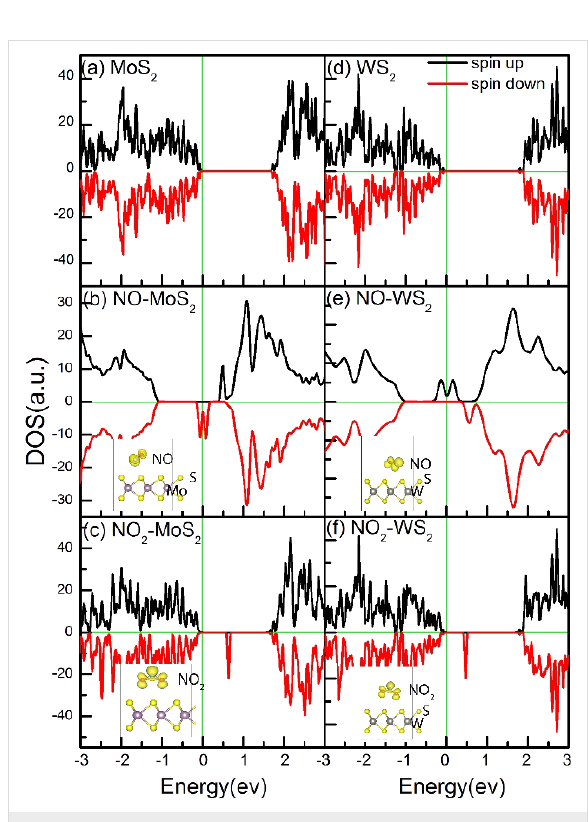
Figure 2: (a–c) TDOS and magnetic charge distribution of (a) the pris- tine MoS 2 monolayer, and MOS 2 with (b) adsorbed NO and (c) adsorbed NO 2 . (d–f) TDOS and magnetic charge distribution of (d) the pristine WS 2 monolayer, and WS 2 with (e) adsorbed NO and (f) adsorbed NO 2 . The Fermi level is indicated by the vertical green